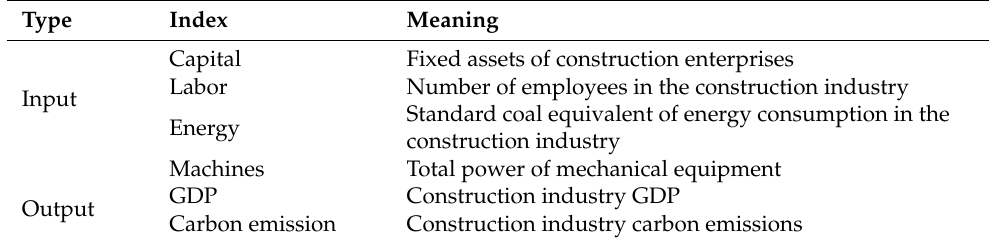
Table 1. The input–output index of the